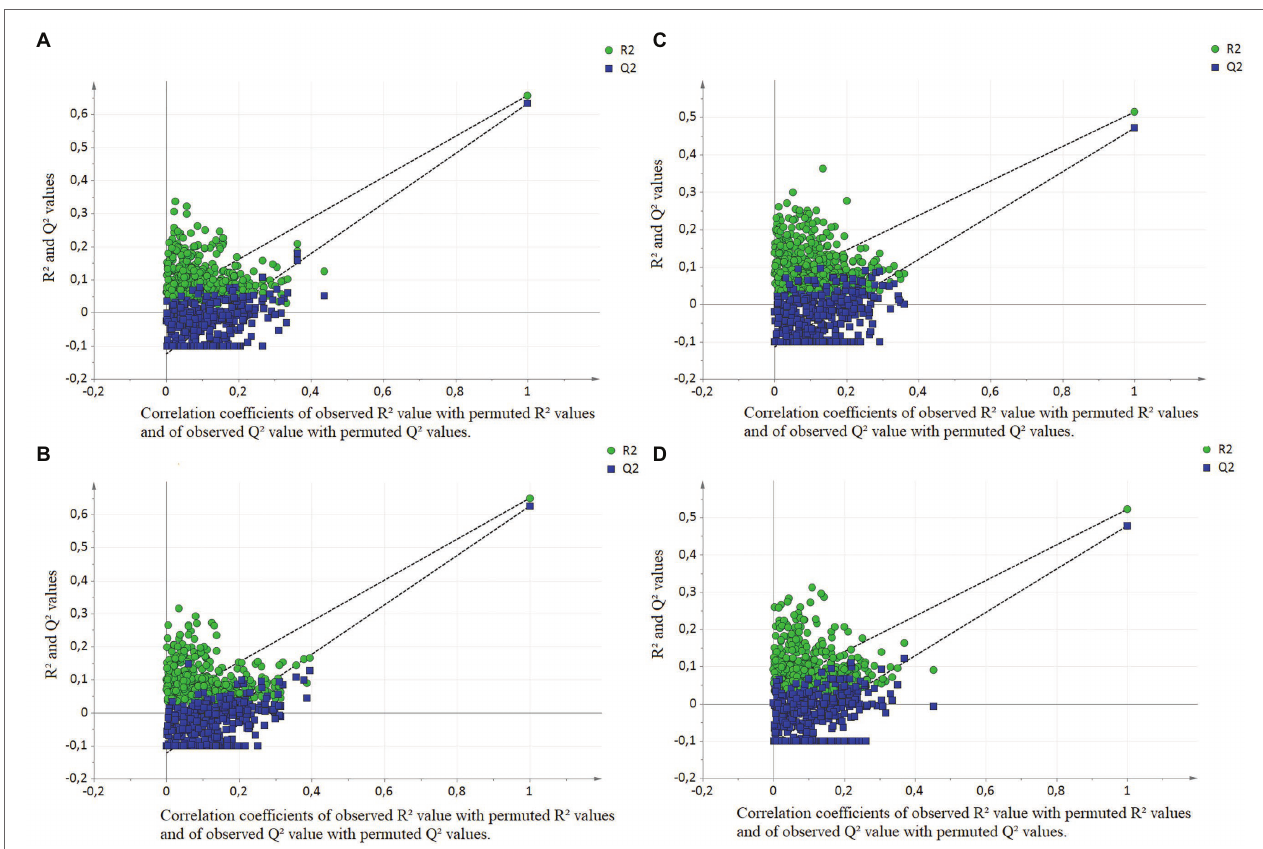
FIGURE 3 | Permutation plots (A) for liver weight with the bucket method, (B) for liver weight with the metabolite method, (C) for liver technological yield with the bucket method, (D) for liver technological yield with the metabolite method. 500 permutations were performed. The permutation plot shows, for a selected Y-variable, on the vertical axis the values of R 2 Y and Q 2 for the original model and of the Y-permuted models. The horizontal axis shows the correlation between the permuted Y-vectors and the original Y-vector for the selected Y. The original Y has a correlation of 1.0 with